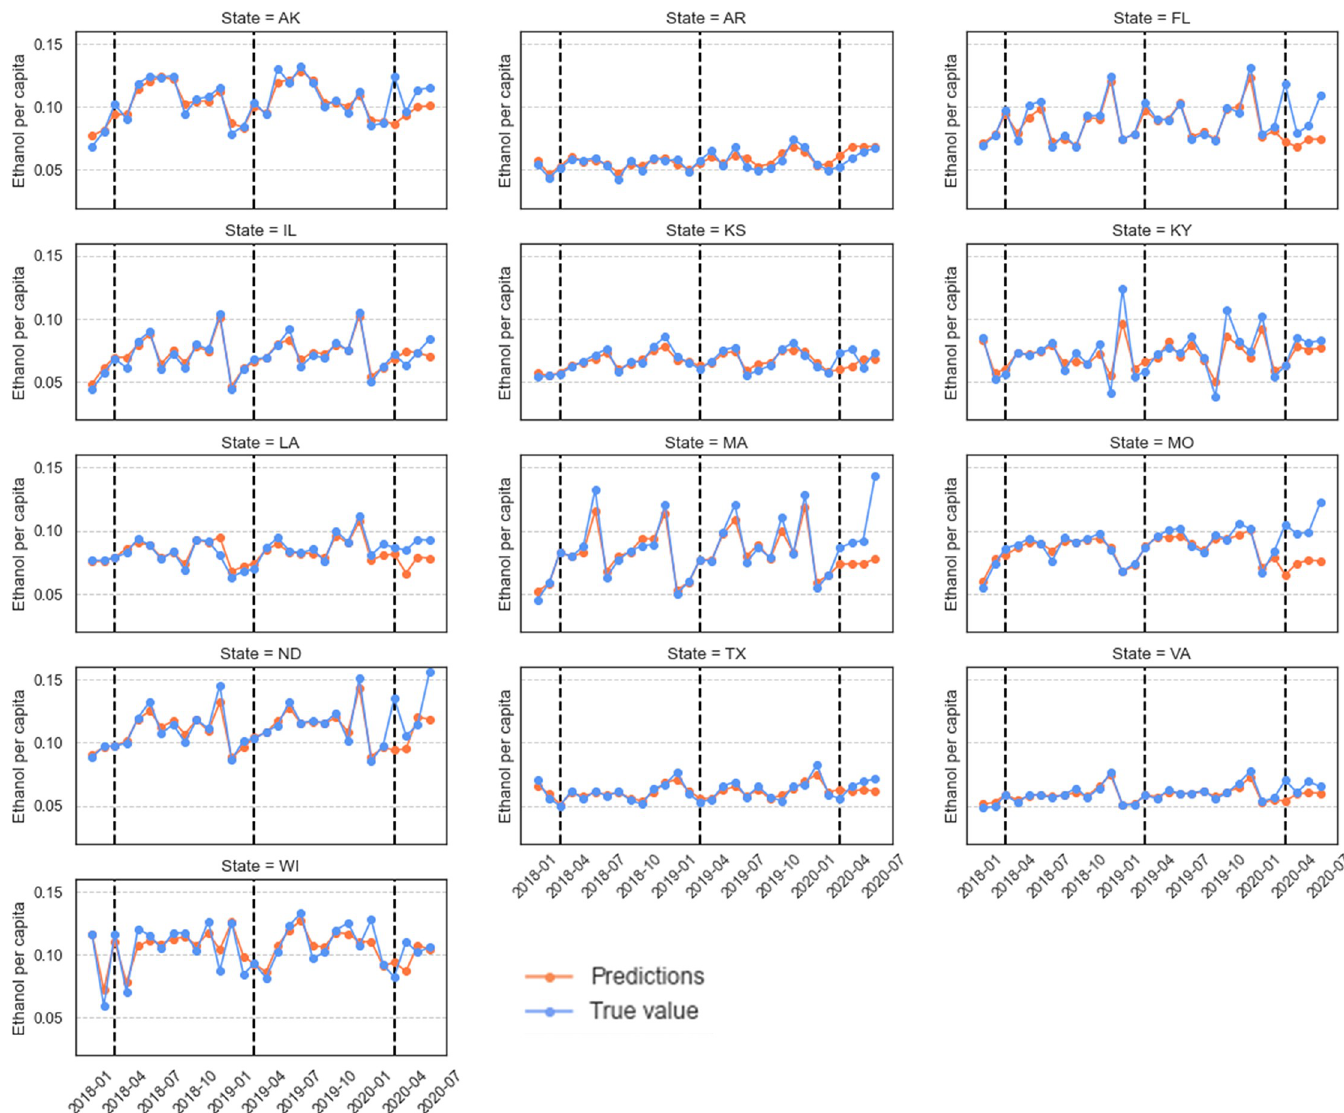
Fig 13. Model estimates and the recorded per capita sales of spirits in individual states. The vertical dashed lines indicate the month of March in 2018, 2019, and 2020. The model was trained on data before March 2020 and was then used to predict the sales for the months following (and including) March 2020.